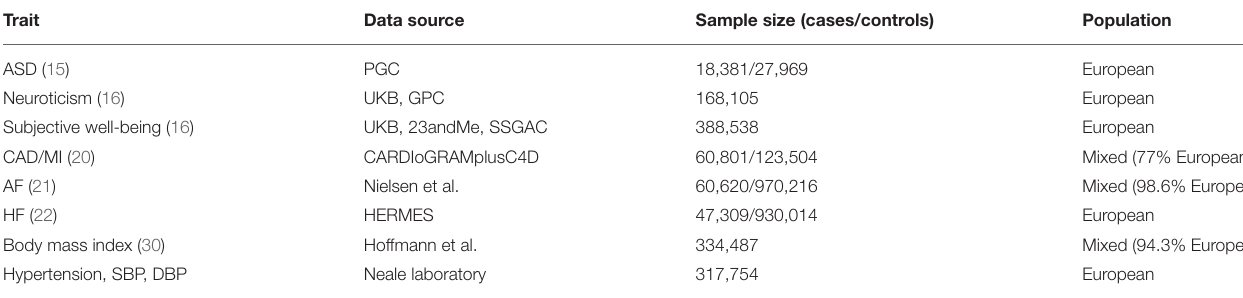
TABLE 1 | Description of data sources included in the MR analyses.